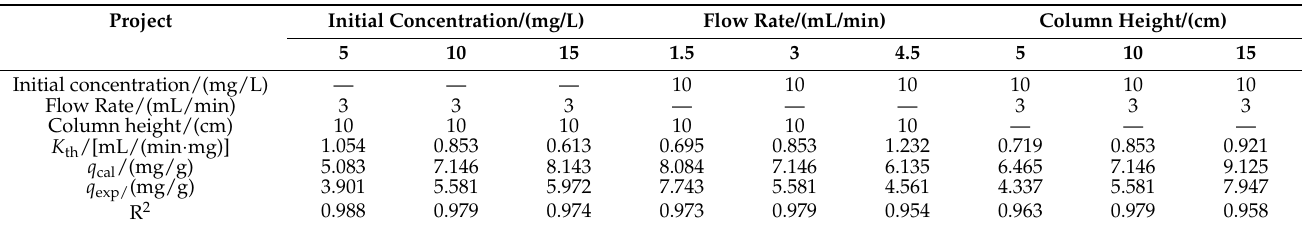
Table 6. Thomas parameters for different conditions.